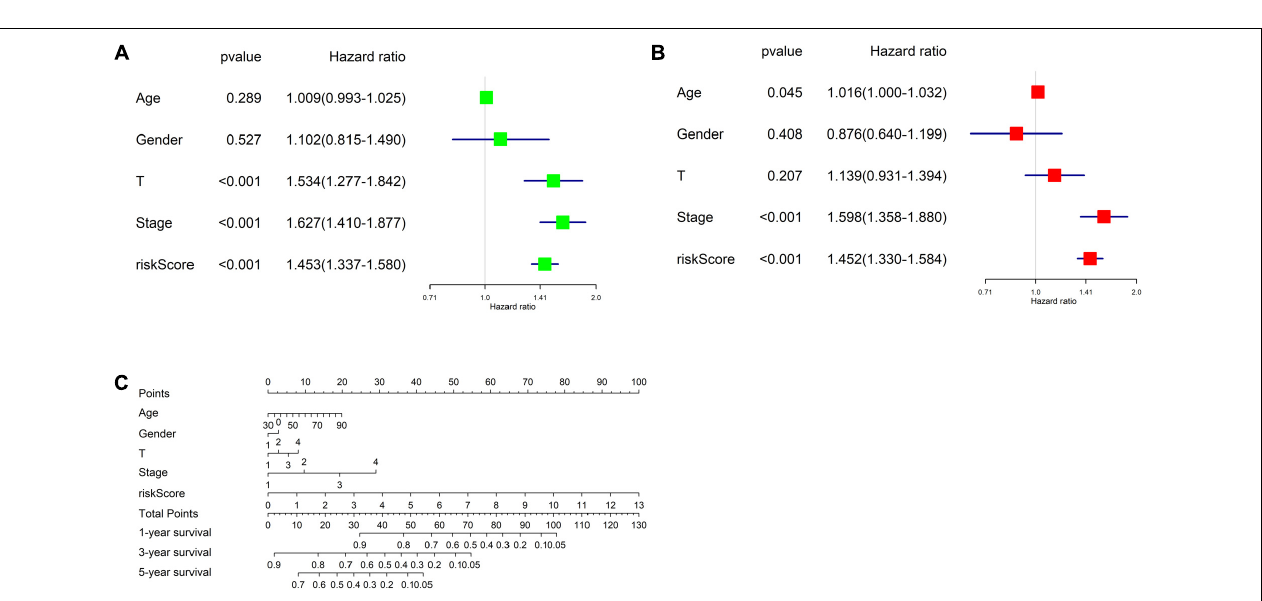
FIGURE 6 | Survival analysis of eight signature genes in GEPIA website. (A–H) Survival analysis of GPX3, TCN1, ASPM, PCP4, CAV2, S100P, COL1A1, and SPOK2 in GEPIA database.